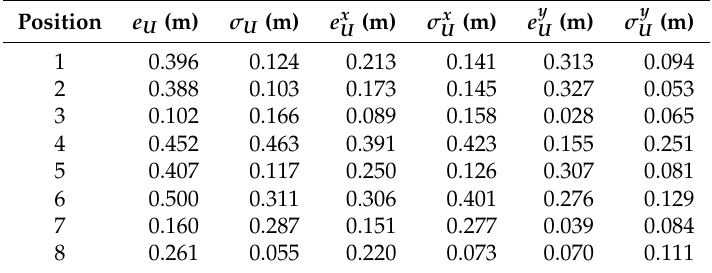
Table 11. Measured accuracy of the POST U algorithm in Scenario 4.